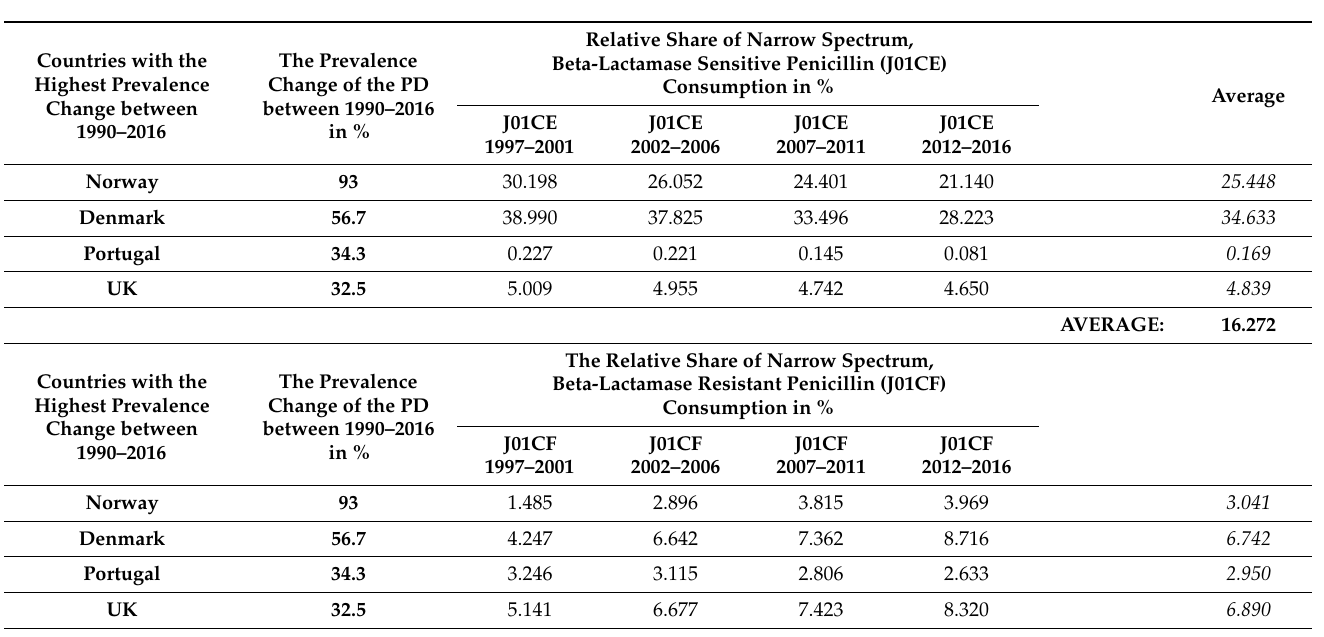
Table 5. Comparison of the consumption of narrow-spectrum penicillin (J01CE, J01CF) in countries with the highest prevalence change of PD and the countries with decreased prevalence of PD. The higher consumption of narrow-spectrum penicillin (J01CE, J01CF) promoting the prevalence of PD is well observed in the countries with the top highest prevalence of PD, while, in the countries showing a decreasing prevalence of PD, a reduction in the consumption of narrow-spectrum penicillin (except for Portugal/J01CF/) is seen in the 5-year periods. The difference between the consumption of narrow-spectrum, beta-lactamase sensitive penicillin in countries with a higher increase in PD prevalence is nearly 6-fold compared to countries showing a reduction in the prevalence of PD between 1990–2016, while the difference in the consumption of narrow-spectrum, beta-lactamase resistant penicillin is